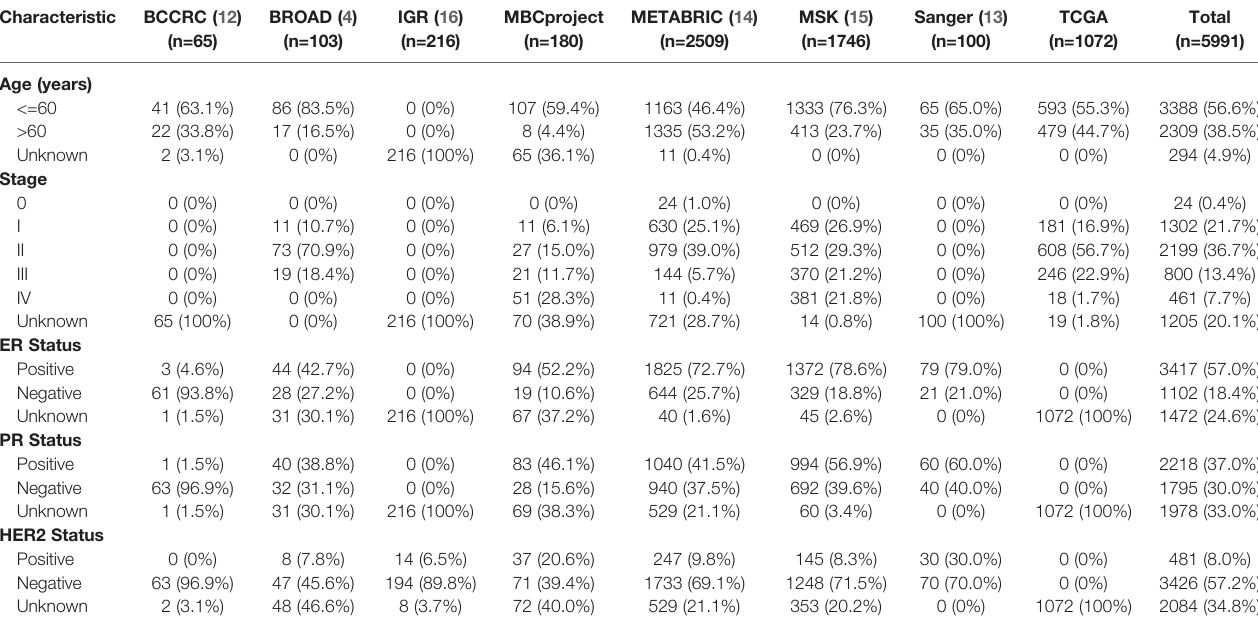
TABLE 3 | Summary of clinical information of 5991 patients from eight